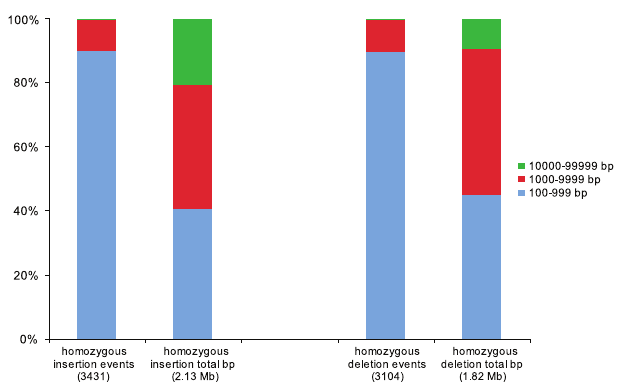
Figure 7. Number and Length Distribution of Apparent Homozygous Insertion and Deletion Sequences Greater than 100 bp Note that the number of indel events are similar but that there are more longer insertions than